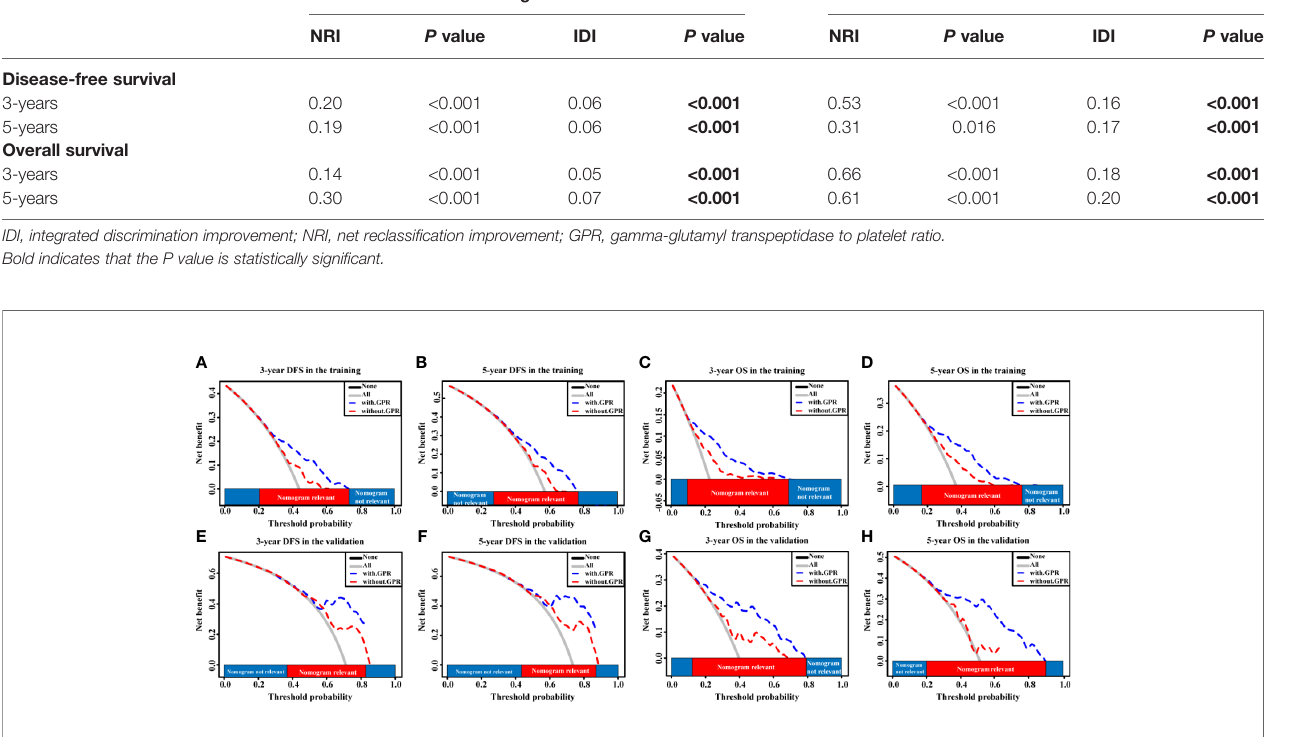
TABLE 5 | Comparison of the NRI and IDI of the nomogram model with and without GPR. With GPR VS. Without GPR